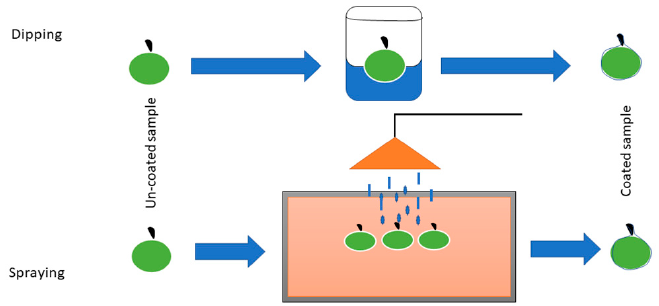
Figure 3. Different coating techniques applied in literature for casein-based coatings.